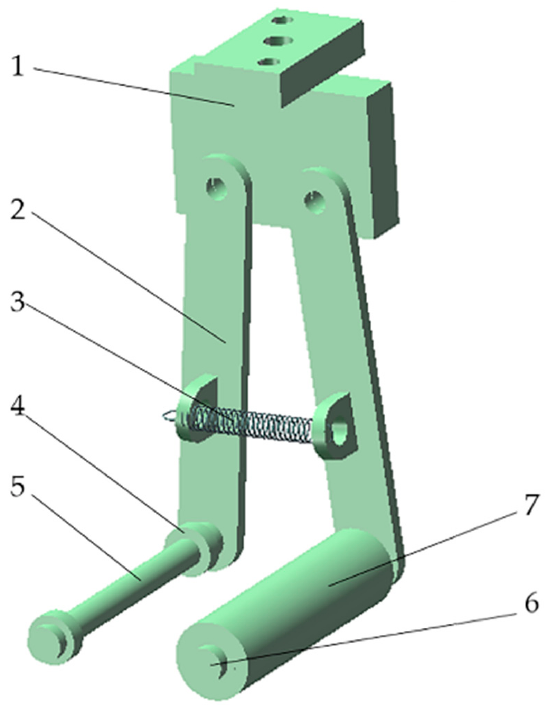
Figure 6. 3D model of seedling pressing mechanism. 1. Connecting block. 2. Connecting rod. 3. Spring. 4. Bearing. 5. Shaft. 6. Bearing retaining ring. 7. Seedling pressing